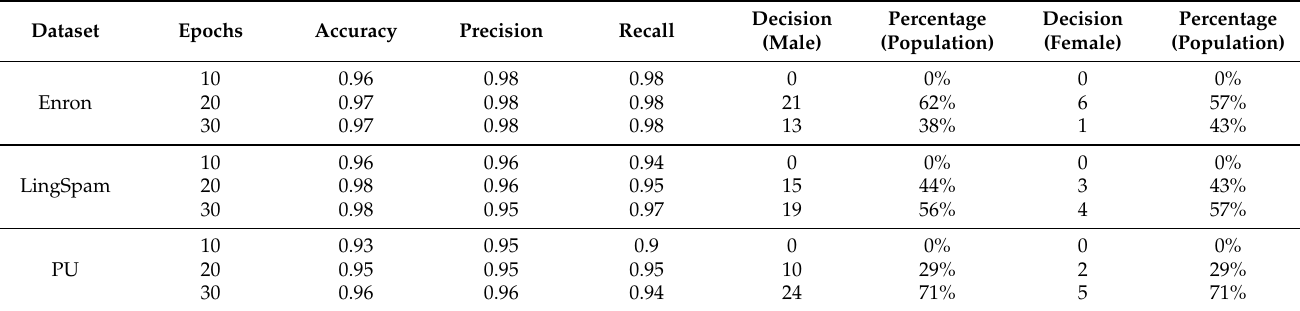
Table 8. Summary of extrinsic evaluation for the LSTM